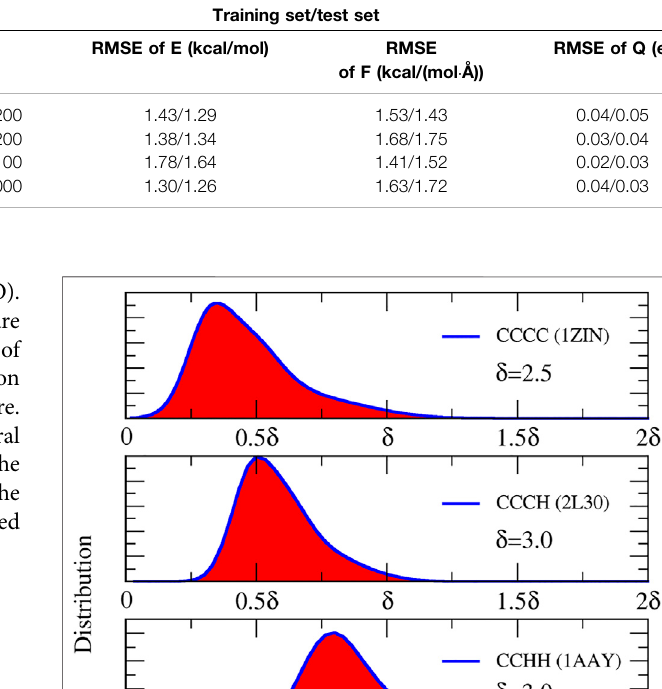
TABLE 1 | The performance of NN potentials on four zinc-containing proteins with different coordination modes. MBG type